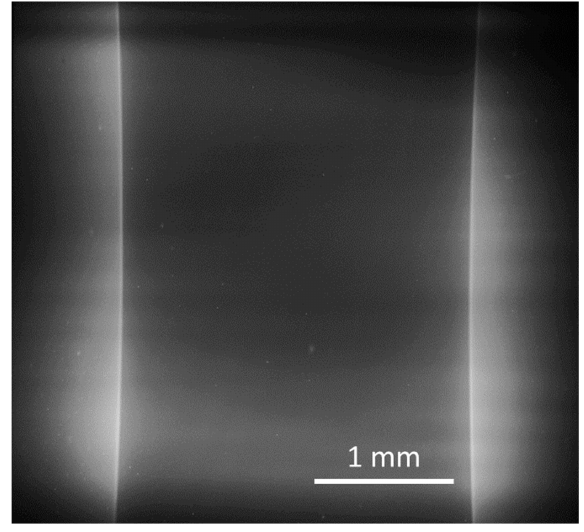
Figure 5. Example of a radiograph.